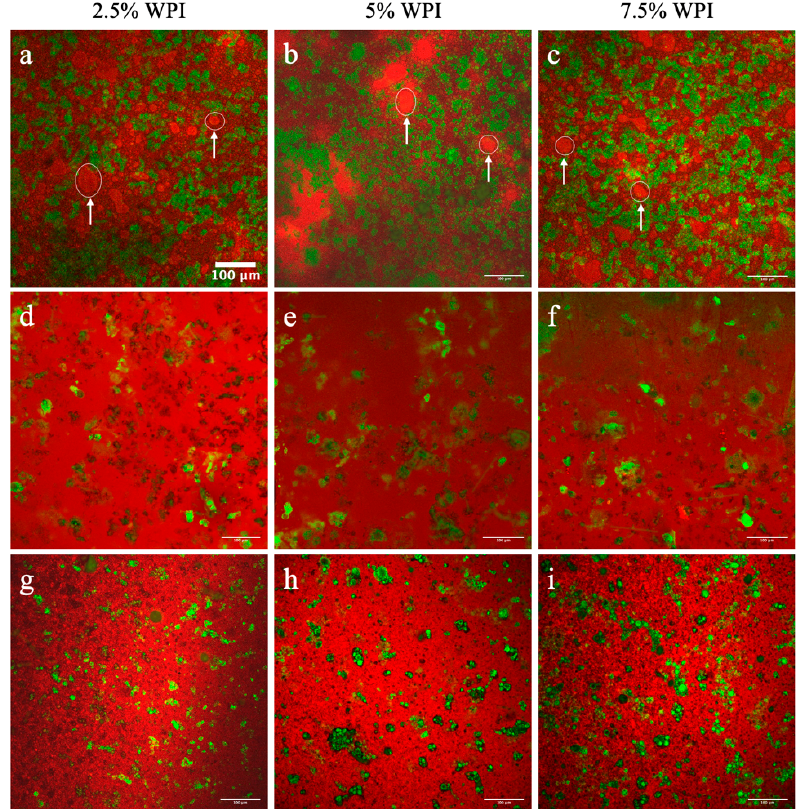
Figure 8. Confocal microscopy images of: ( a – c ) CE samples, ( d – f ) HOC samples gelled with 1% RBW, and ( g – i ) HOC samples gelled with 10% RBW. The lipid component is shown in red and the protein network is displayed in green.